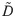
Evolution of Brazilian states in the ECI-Income plane.a) The figure shows the dynamics (from 2002 to 2015) of the Brazilian states in the ECI-Income plane, where the GDPp is in logarithmic scale. Only the state of São Paulo and the Distrito Federal appear to be clearly distinguishable from the rest of the states. All the others states are indeed concentrated in a small region of the graph. b) The figure shows the coefficient D˜ calculated considering the time interval 2003-2013. Colors vary from green (where the versors tend to be parallel), to red (where the versors tend to be unevenly directed). From the figure we can therefore verify that there is a low predictability of the evolution of all the states. c) Here we show a grid where for each cell we calculate the versor of the sum vector. From the figure we see that there is no privileged direction, indeed the vectors are unevenly directed.